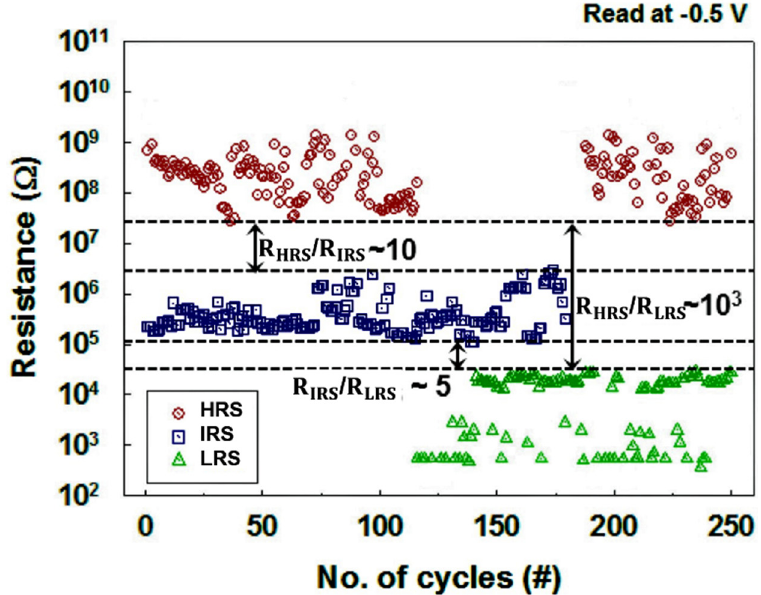
/ Ni / SiO / p + -Si memory x N y